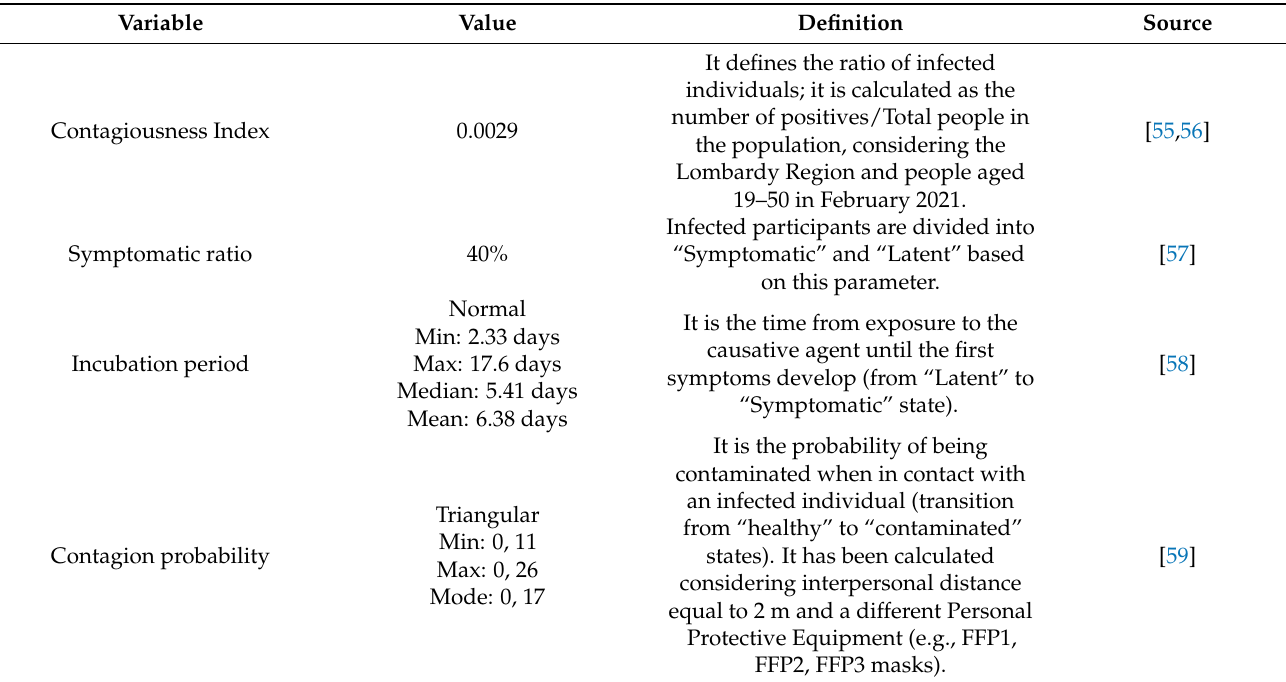
Table 5. Agent-based model